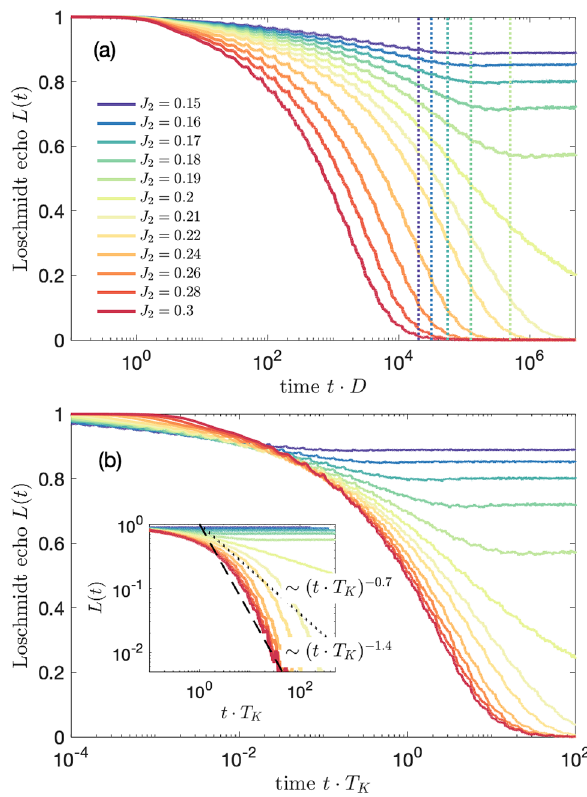
Figure 10. ( a ) The Loschmidt echo L ( t ) for quantum quench in the coupling strength J 2 from J 2 = 0 to the value shown in the legend, with fixed J 1 = 0.2 . ( b ) The Loschmidt echo plotted vs time rescaled with the Kondo temperature T K , where T K ≈ D exp ( − 1 /ρ J 2 ) . The vertical dashed lines in ( a ) indicate the time scale t ∗ = α/ T ∗ for J 2 < 0.2 , where α is a numerical factor of the order of unity. The other parameters are the same as in Fig.